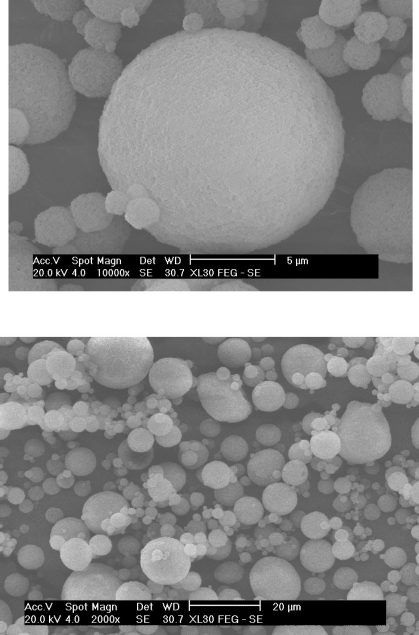
FIGURE 3 - SEM micrographs of feverfew spray-dried extract (x 10,000, 2,000).